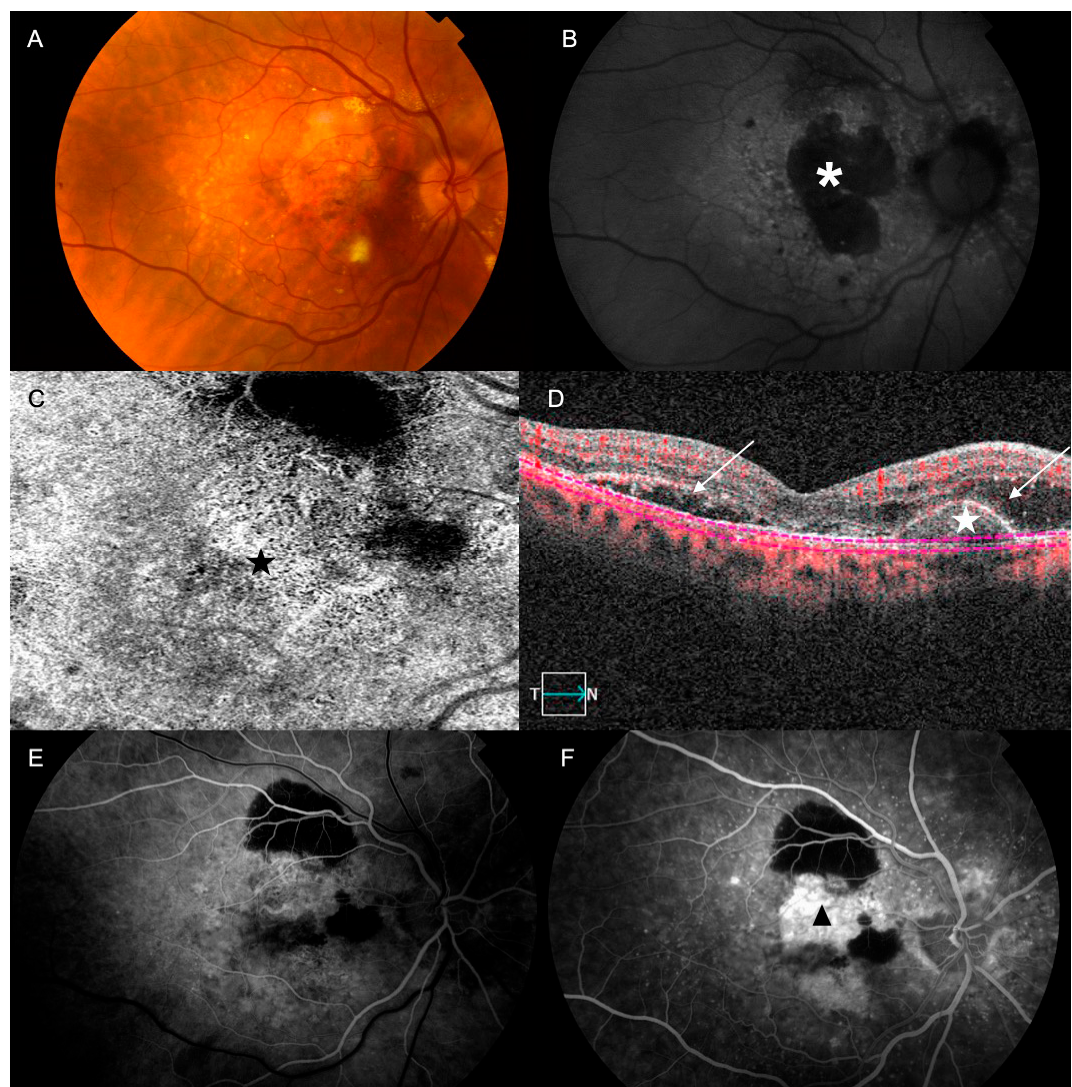
Figure 2. ( A–F ) Color, optical coherence tomography (OCT) and fundus fluorescein angiography (FFA) and AF pictures of fundus for retina with changes typical for wet AMD. ( A ) Wet AMD is characterized by abnormal angiogenesis (choroidal neovascularization (CNV)), causing recurrent retinal exudation, subretinal hemorrhage, retinal or pigment detachment and, in the final stages of the disease, subretinal fibrosis (disciform scar). ( B ) AF showing confluent atrophic patches ( asterisk ) with a banded pattern of increased AF in the junction. The CNV can be seen in the OCT-angiography ( black star ); ( C ) the structural OCT enables the identification of the abnormal vascular tree ( white star ) and the presence of subretinal fluid ( arrows ) ( D ). By doing an FFA, we can also confirm the presence of the CNV: ( E ) Early phase: stippled hyperfluorescence with adjacent masking areas by blood or subretinal fibrosis; ( F ) Late phase: The hyperfluorescence increases irregularly due to the presence of progressive leakage ( black arrow-head ).